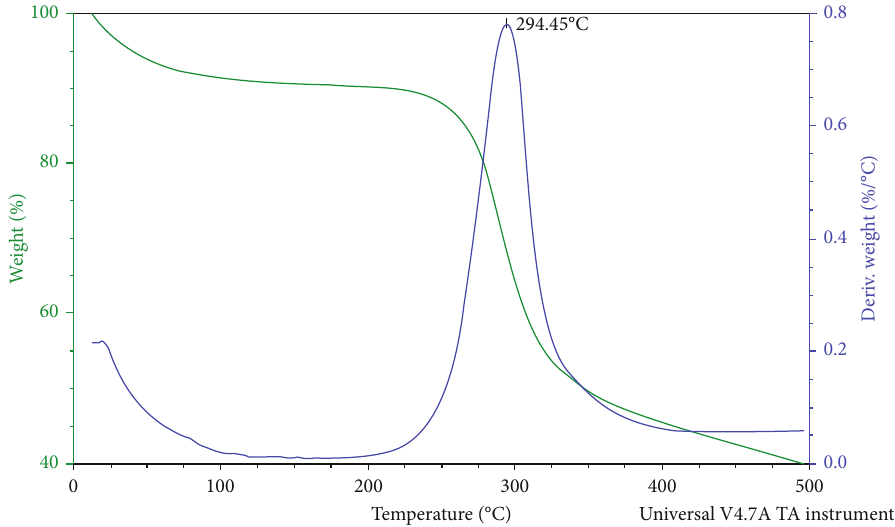
Figure 8: TGA Au [A]-Qs QDs. The decomposition temperature of the compound (294.45 ° C) at a heating rate of 10 ° C/min in gas nitrogen fl